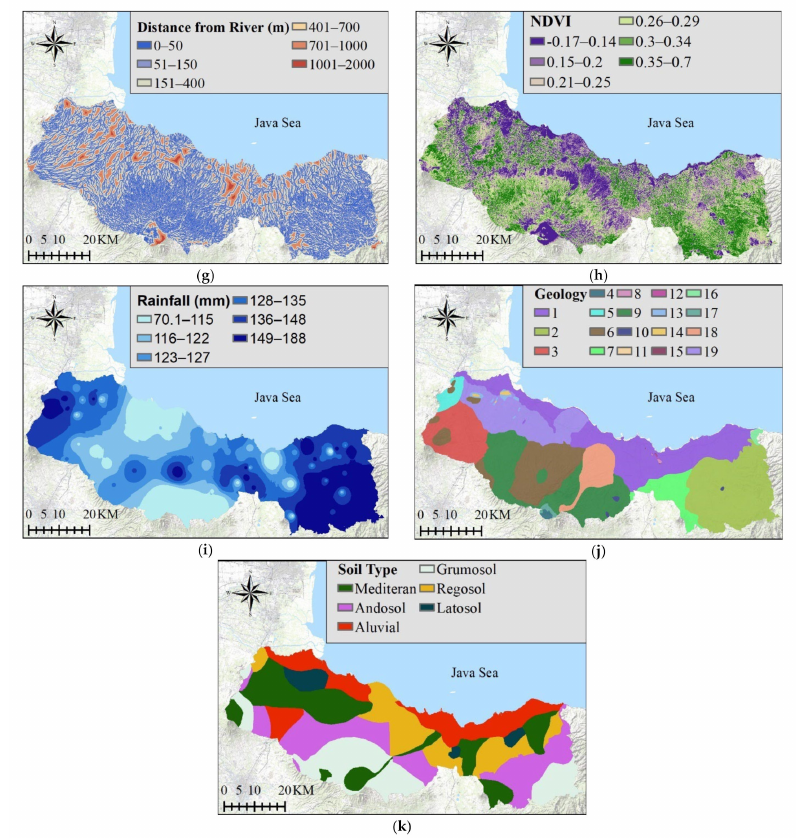
Figure 3. Input thematic layers: ( a ) elevation, ( b ) land use, ( c ) flow accumulation (FA), ( d ) topographic wetness index (TWI), ( e ) stream power index (SPI), ( f ) NDVI, ( g ) distance to rivers (DR), ( h ) river density (RD), ( i ) rainfall intensity, ( j ) soil type, and ( k )